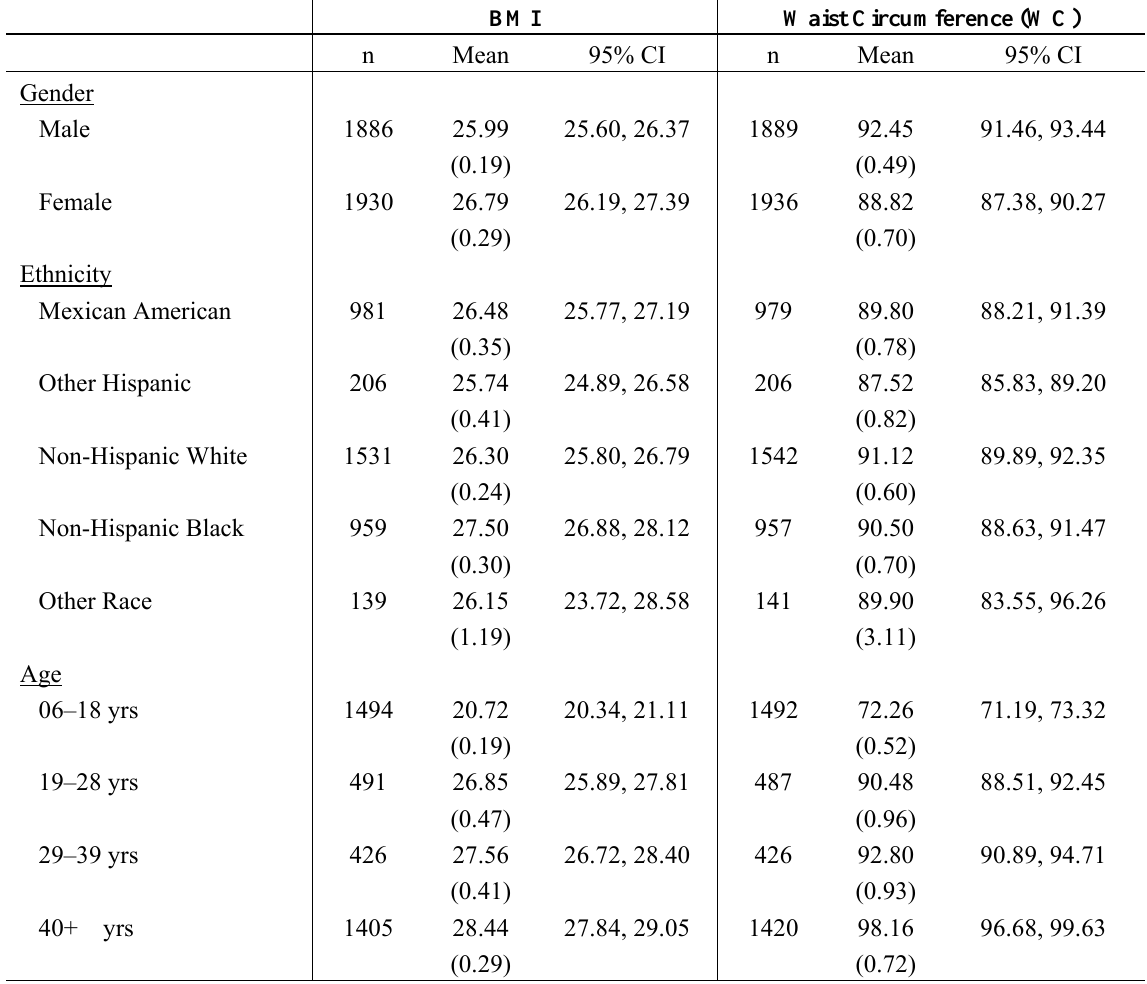
Table 1. Descriptive Statistics for Detectable